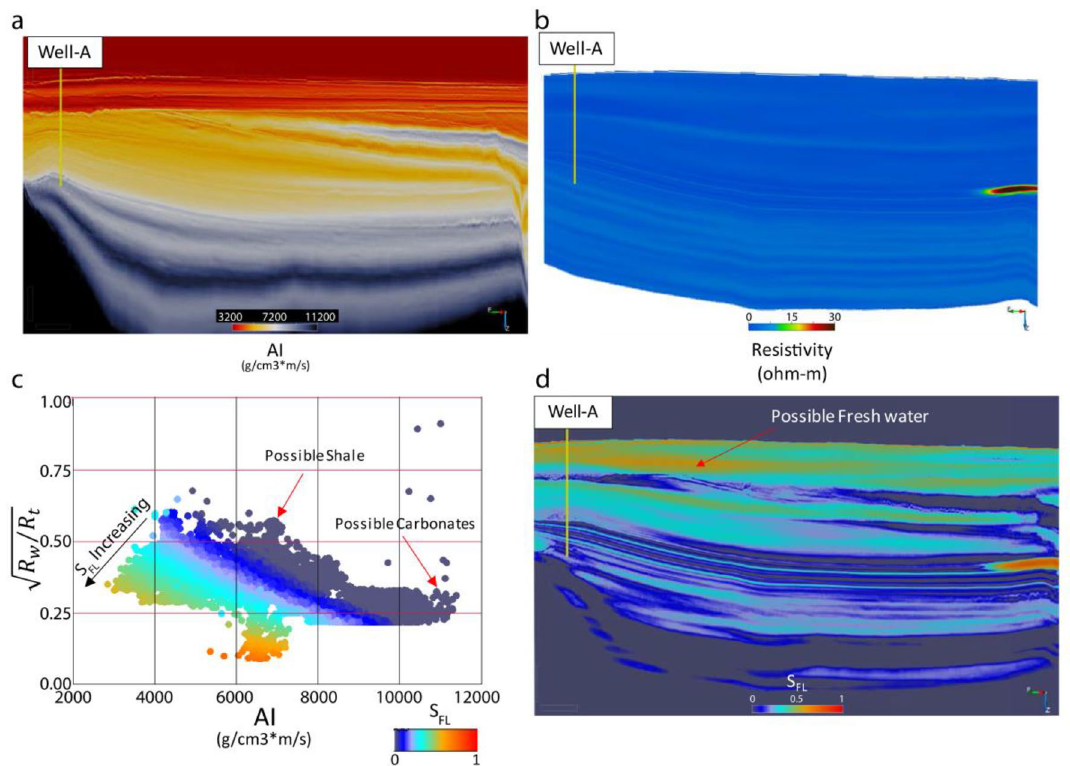
Figure 2. An example of fluid (oil in this case) response using synthetic data, ( a ) AI profile with a dry well (Well-A), ( b ) An oil accumulation on extreme west exhibiting an anomaly on the resistivity section that is not obvious on the AI profile ( a ), ( c ) The AI-Resistivity ratio function ( √ R w / R t ) plane showing that the fluid effect can be isolated and quantified using our proposed technique, ( d ) the resulting fluid saturation profile indicating oil anomaly and possible (Fig. 3b). The amount of CO 2 considered sequestering was 1.3 MT/Year employing an injection period of 25 years with an injection rate of 200 tons/hr. The Smeaheia area is bounded by a fault array separating the Troll oil and gas field in the west and the Basement Complex in the east. Sognefjord Formation (Upper Jurassic) sandstone is the main CO